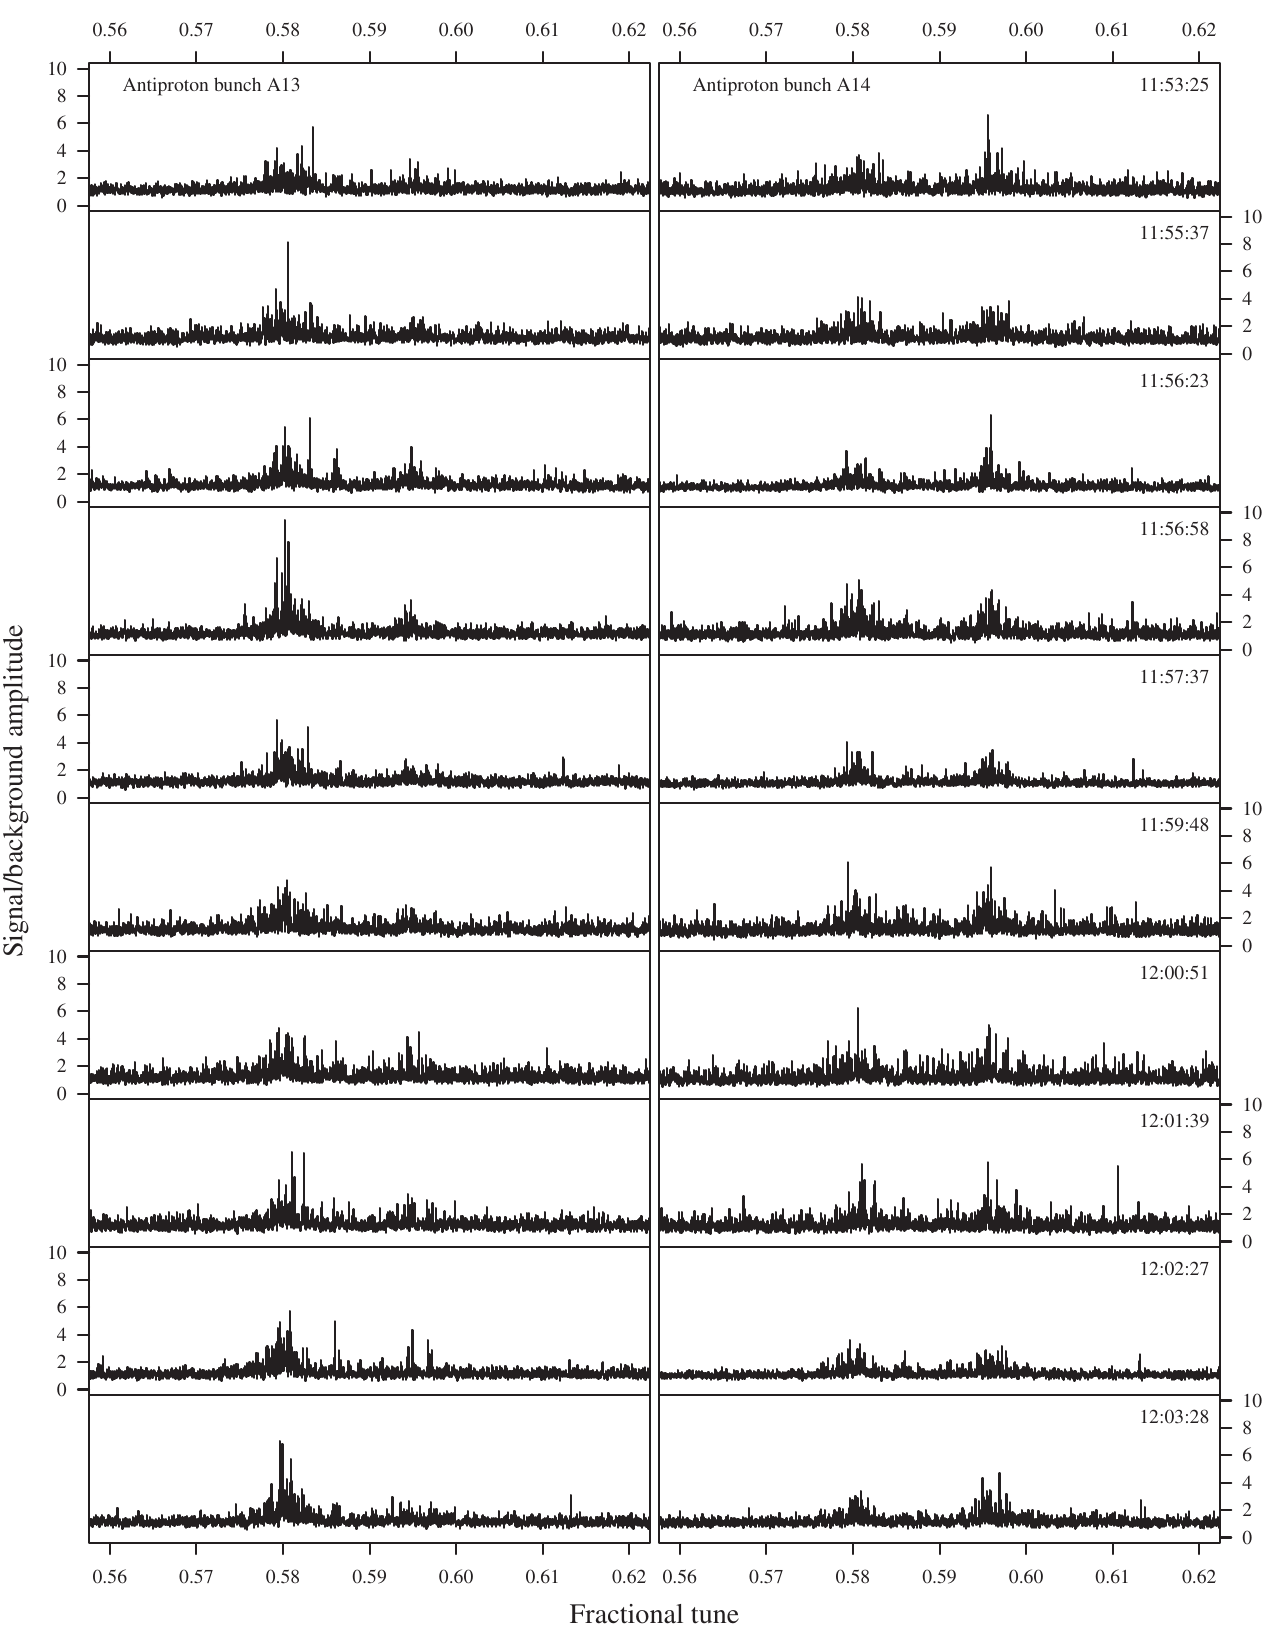
FIG. 6. Repeated measurements on 2 antiproton bunches during Store